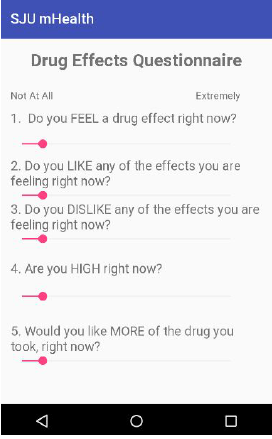
Figure 3. Ecological Momentary Assessment for Medication Efficacy Slider user interface elements calibrated for a score between 1 (not at all) to 10 (extremely) are